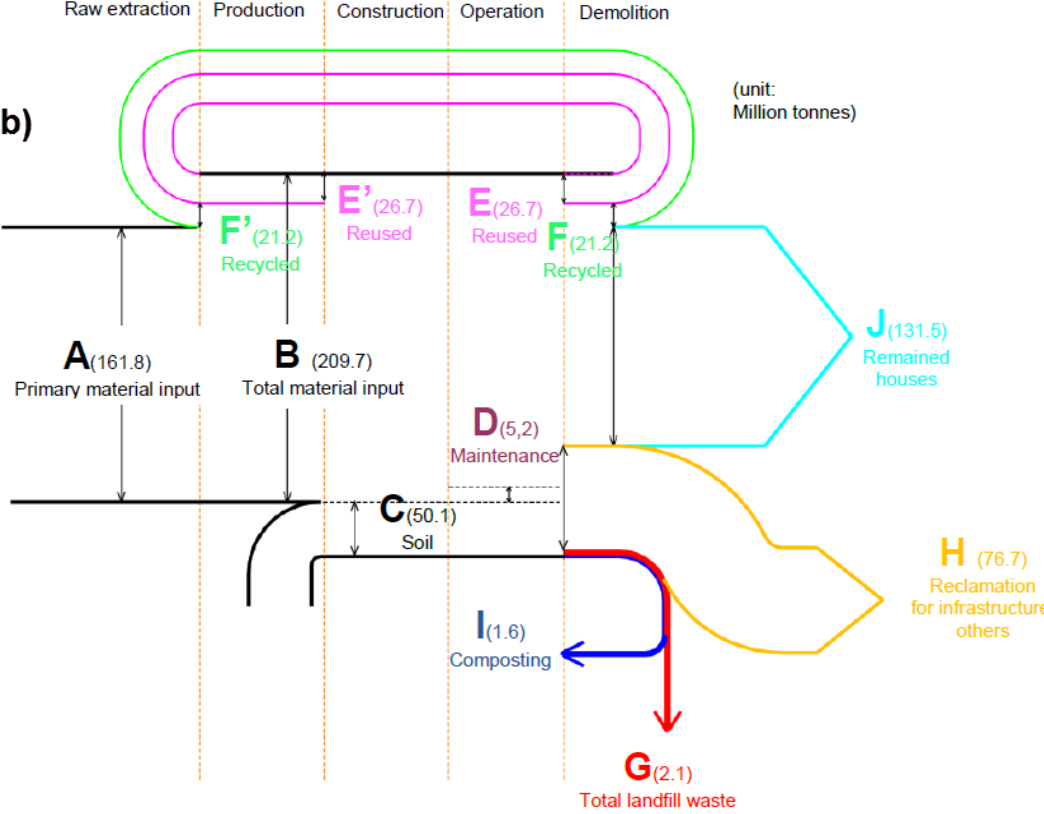
Figure 4. Flow of building materials for individual houses in Jakarta by 2020 (all houses): ( a ) Scenario 1 and ( b ) Scenario 2.